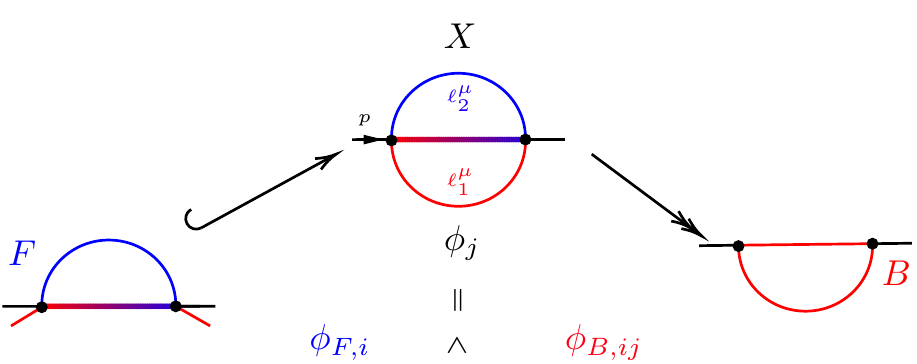
Figure 1 . A sketch of a loop-by-loop fibration of the sunrise graph. The fibre space F is defined as the subspace of X spanned by ‘ , which is the loop momentum running into the one-loop sub-bubble 2 shown on the bottom left. For each different value of the base parameter ‘ one-loop